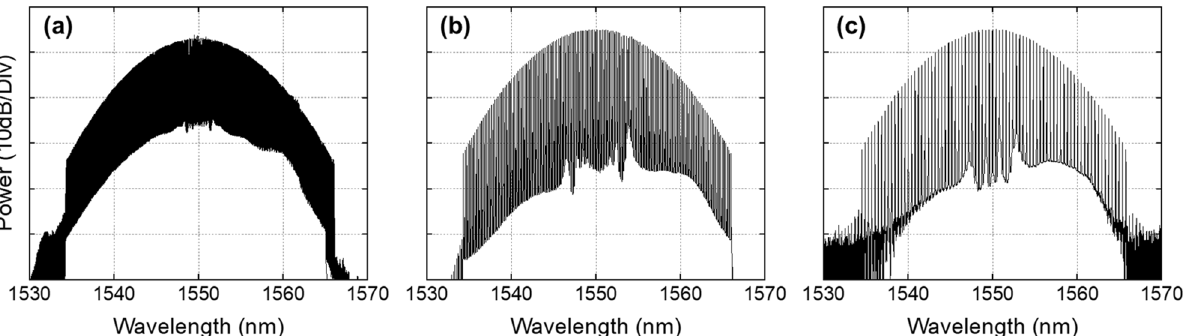
Figure 5. Spectral shaping results with a same quasi-super-Gaussian apodization at repetition rates of ( a ) 10, ( b ) 25, and ( c ) 50 GHz.